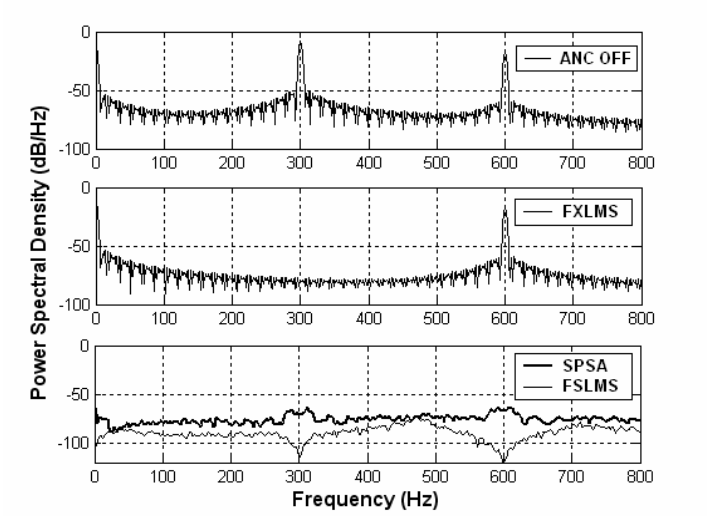
Fig. 6. The error signal spectrum for case